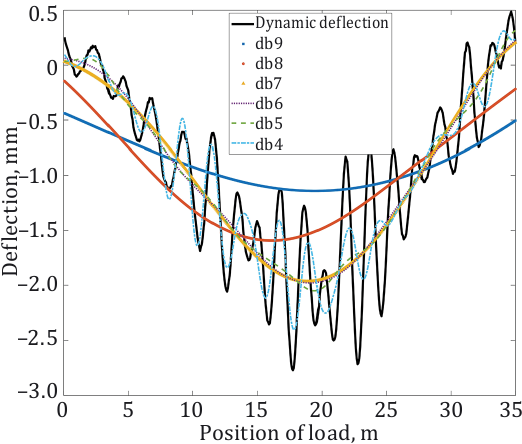
m0 Figure 11. Identified results with dbN method using different N Position of load,